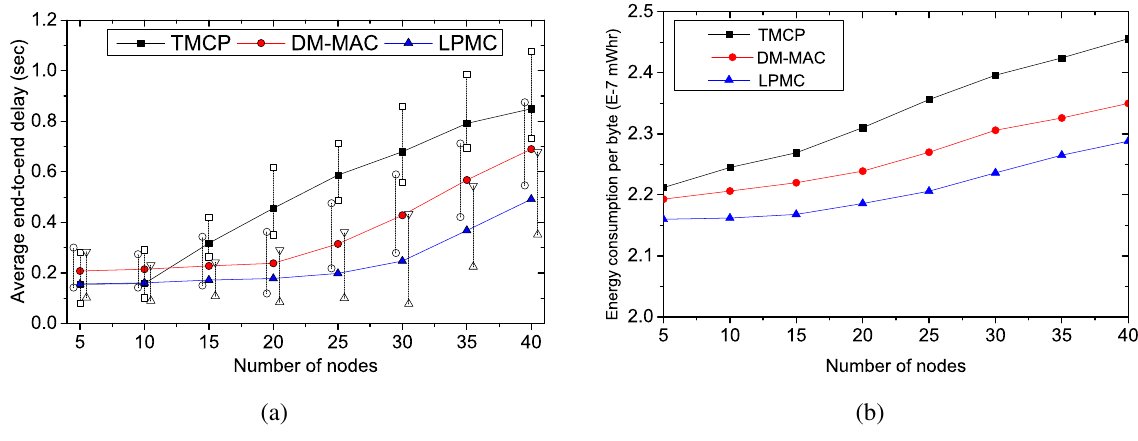
Figure 7. Performance with varying number of sources from a randomly selected